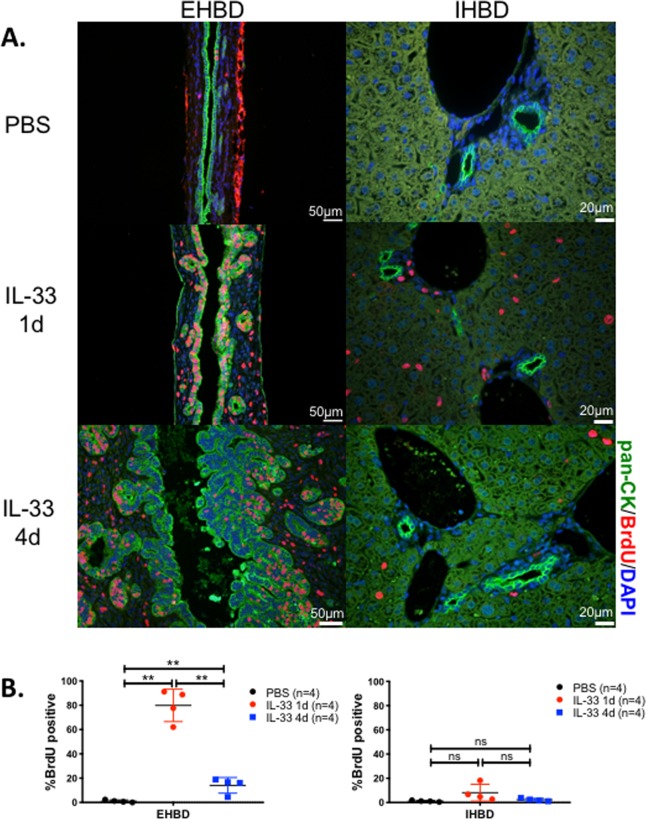
IL-33 induced cholangiocyte proliferation is restricted to the extrahepatic bile ducts.Balb/c mice (n = 2/group) were injected i.p. with PBS or IL-33 and tissues were harvested 24 hours or 4 days later. Two hours prior to harvest, BrdU was administered i.p. to mark rapidly proliferating cells. (A) Representative sections of EHBD and liver after immunofluorescence staining with anti-cytokeratin (CK;green) and anti-BrdU (red) antibodies with DAPI (blue) nuclear stain. (B) The percentage of BrdU+ cells among all CK+ cells. Data are combined from two independent experiments, n = 4 mice per group total. Mean +/- s.d. ** = p<0.005 by two-tailed Student’s t-test. ns = not significant.